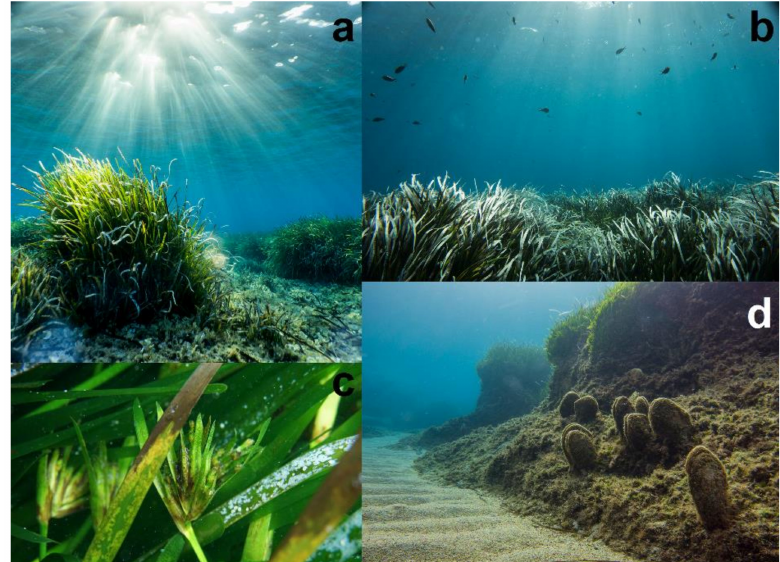
Figure 3. Posidonia oceanica meadow at Isola del Giglio (Tuscan Archipelago, Tyrrhenian Sea, Italy) in good ecological status ( a , b ); P. oceanica flowering ( c ); example of an impacted meadow, showing the lower regression limit with dead matte and dead shells of Pinna nobilis Linnaeus, 1758 ( d ). Photo credit: D.